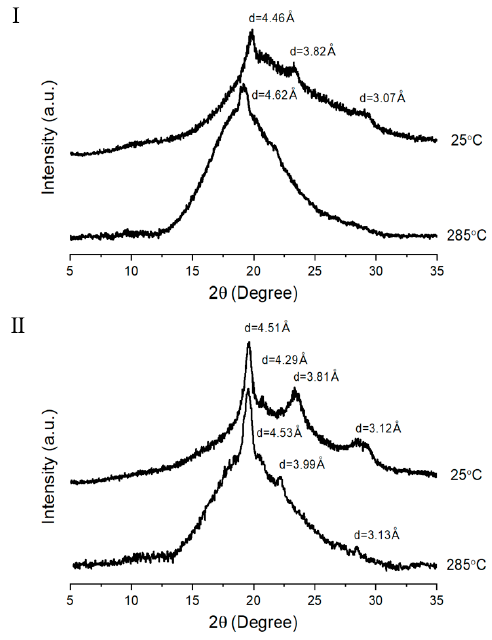
Figure 7. Patterns of sample D in two TLCP series at 25 ◦ C and 285 ◦ C. Figure 7. patterns of sample D in two TLCP series at 25 °C and 285 °C.